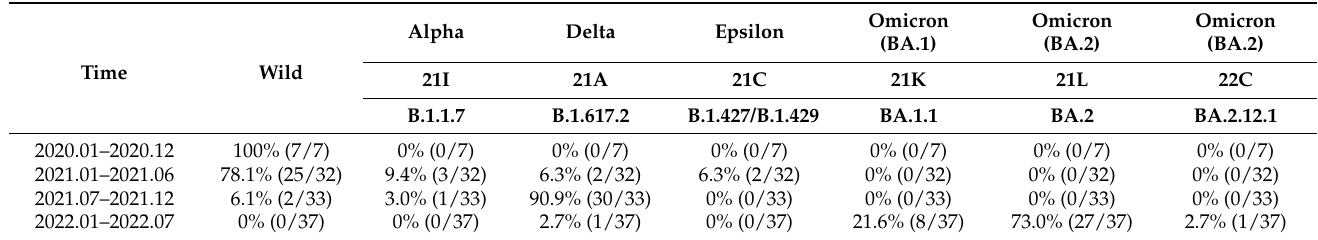
Table 1. Distribution of SARS-CoV-2 strains for 29 months in South